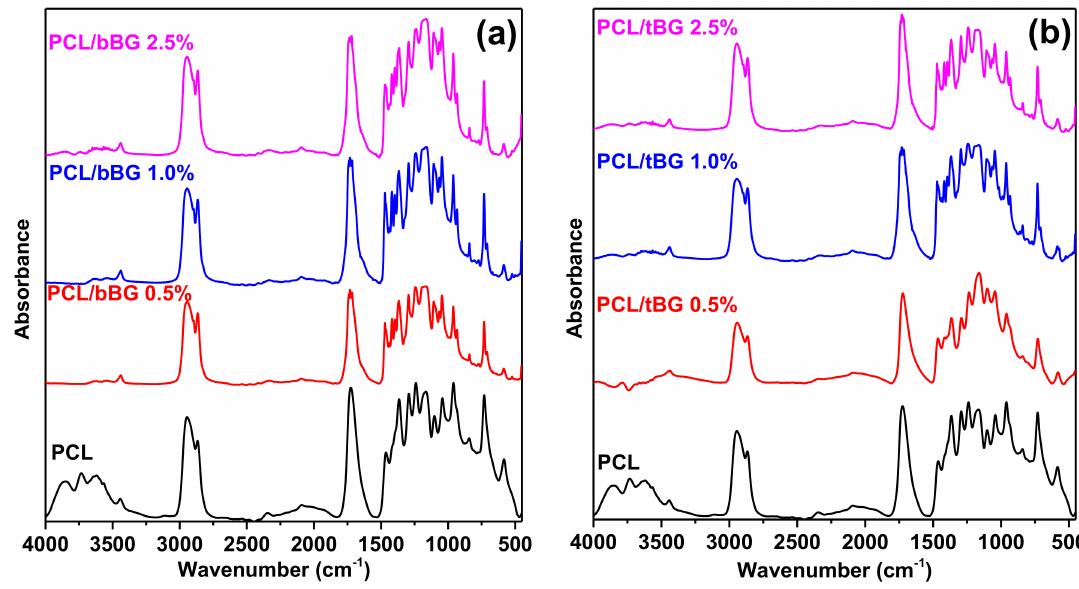
Figure A1. FTIR spectra of ( a ) PCL/bBG and ( b ) PCL/tBG nanocomposites.